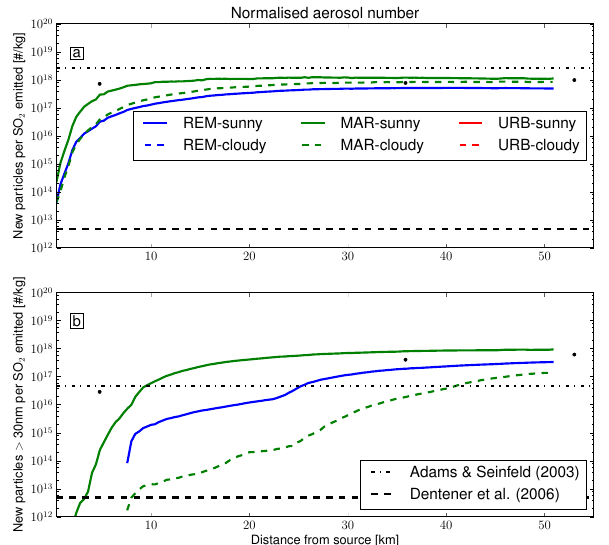
Fig. 9. (a) Total additional predicted particles and (b) additional particles larger than 30nmkg − 1 SO 2 versus distance from the Parish power-plant, for different background aerosol size distribu- tions and differing rates of OH production. See Sect. 3.1 for a de- scription of the calculation. Values are averaged over the plume. Model resolution is 400 × 400 × 40m. Black dots indicate air- craft observations, solid colored lines indicate model results, black dashed lines indicate the values used by Dentener et al. (2006), and black dashed-dotted lines indicate the values used by Adams and Seinfeld (2003). Particle numbers decreased for the REM-cloudy, URB-sunny, and URB-cloudy cases, so these lines are not